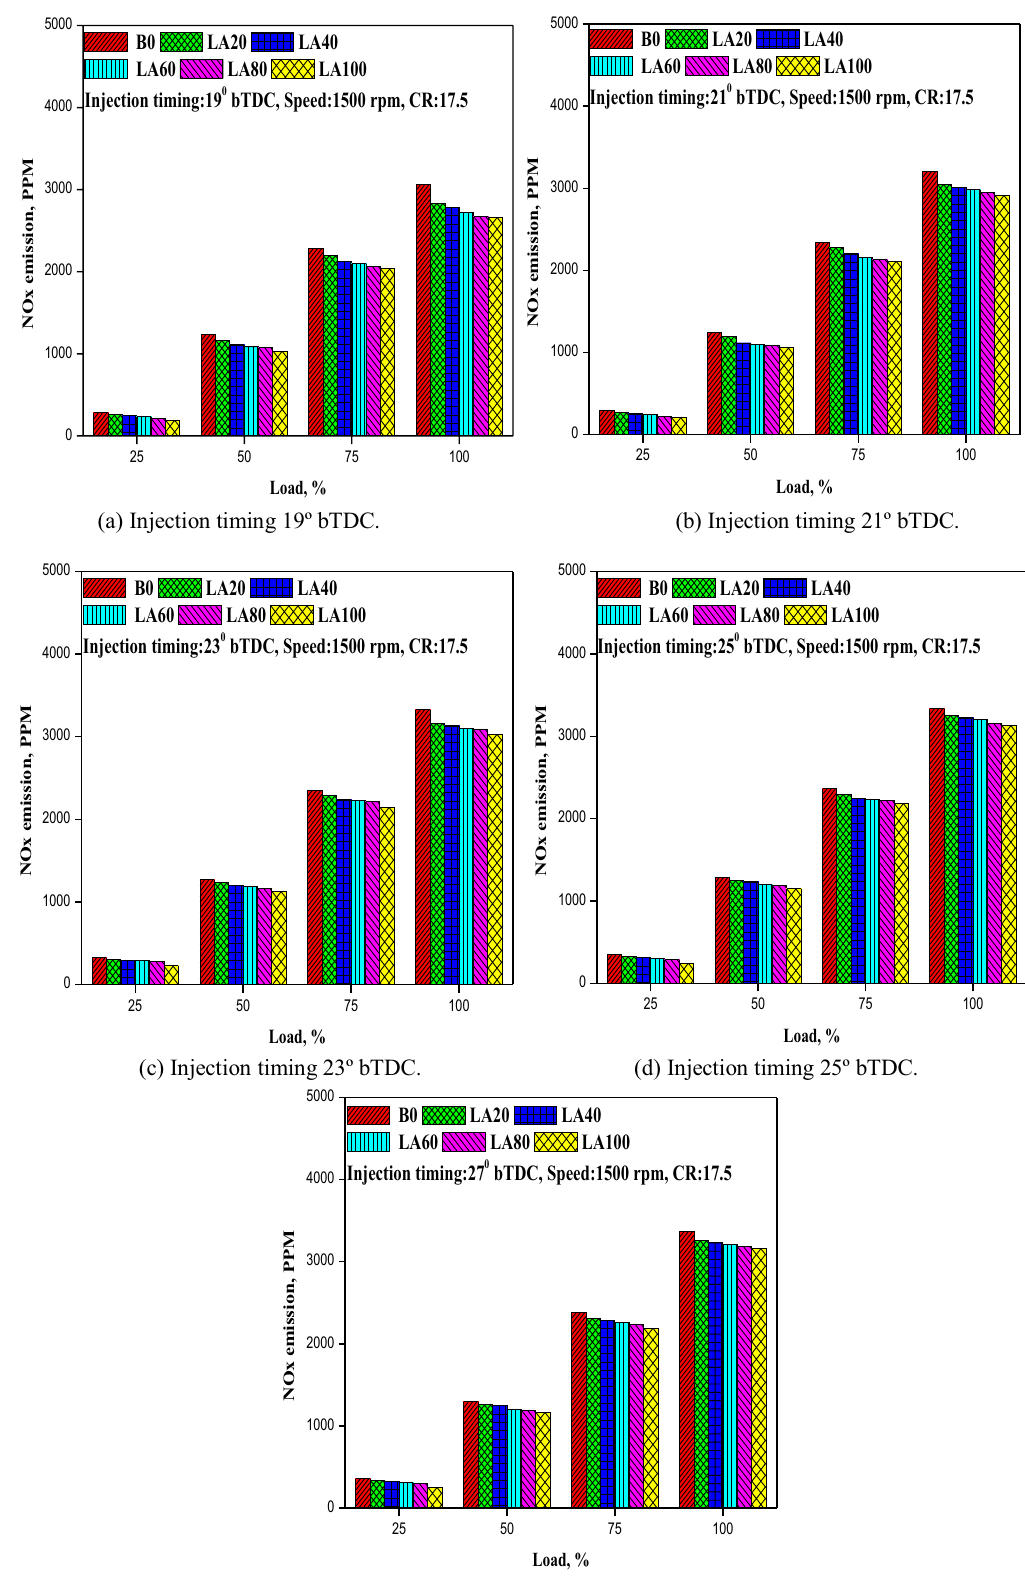
Figure 13. ( a–e ) The variation in NO X emission with different FITs and engine load for considered fuel